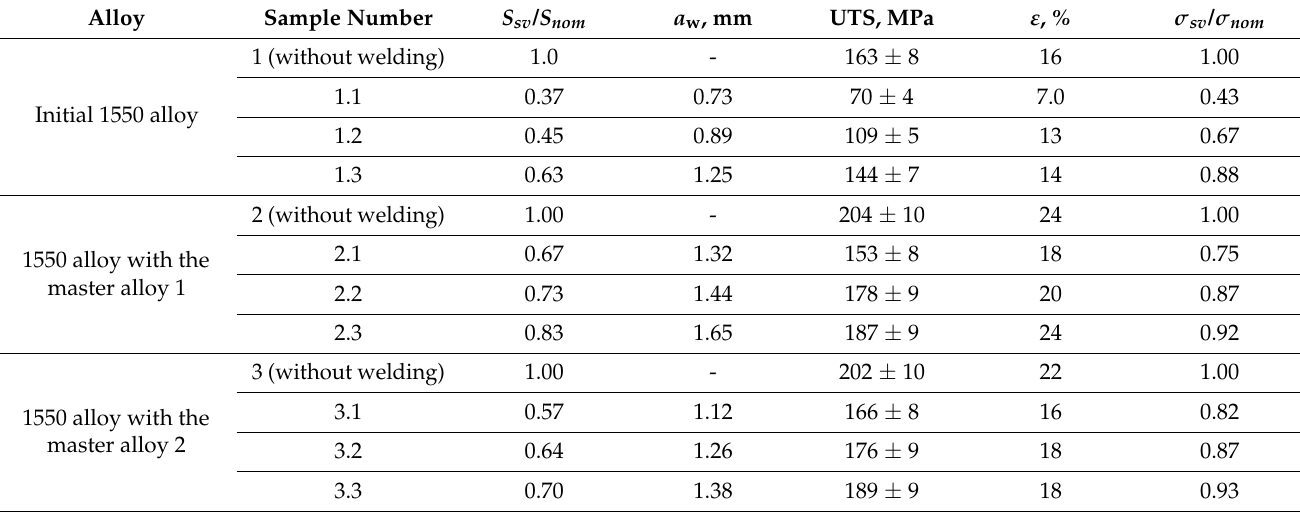
Table 3. Mechanical characteristics of the studied samples.